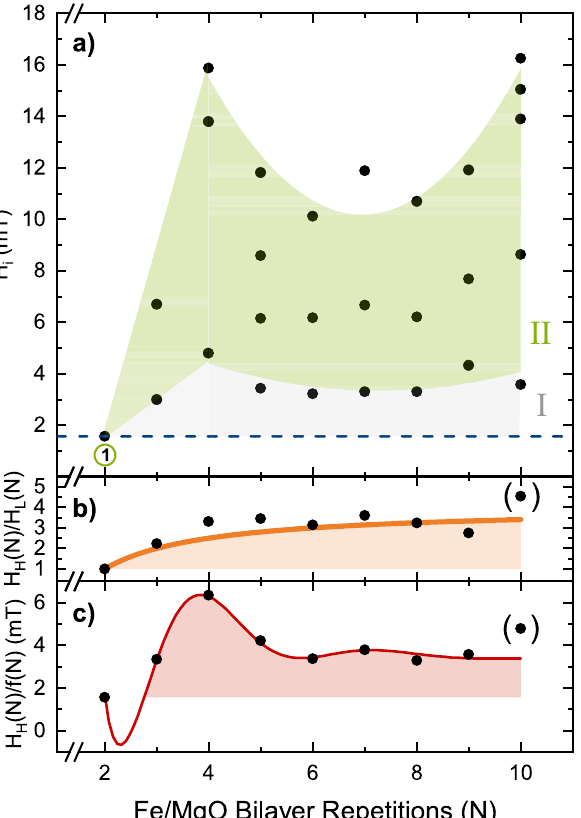
Figure 5. ( a ) Switching fields (ascending hysteresis loop) of the i-th step as a function of bilayer repetitions. Switching field of samples with N = 2 is labeled corresponding to the labeling of the magnetization steps in Fig. 2. The outermost Fe layers switch at the lowest fields due to the weaker interlayer coupling arising from missing neighbors. ( b ) Normalized saturation fields, [ H H ( N )/ H L ( N ) ], and fit f ( N ) (orange line) of the data shown above with H H ( N ) being the highest and H L ( N ) being the lowest switching field of the respective sample. ( c ) H H ( N ) divided by the fit f ( N ) shown above. The fit (red line) corresponds to f ( (cid:31) ) , as described in the text